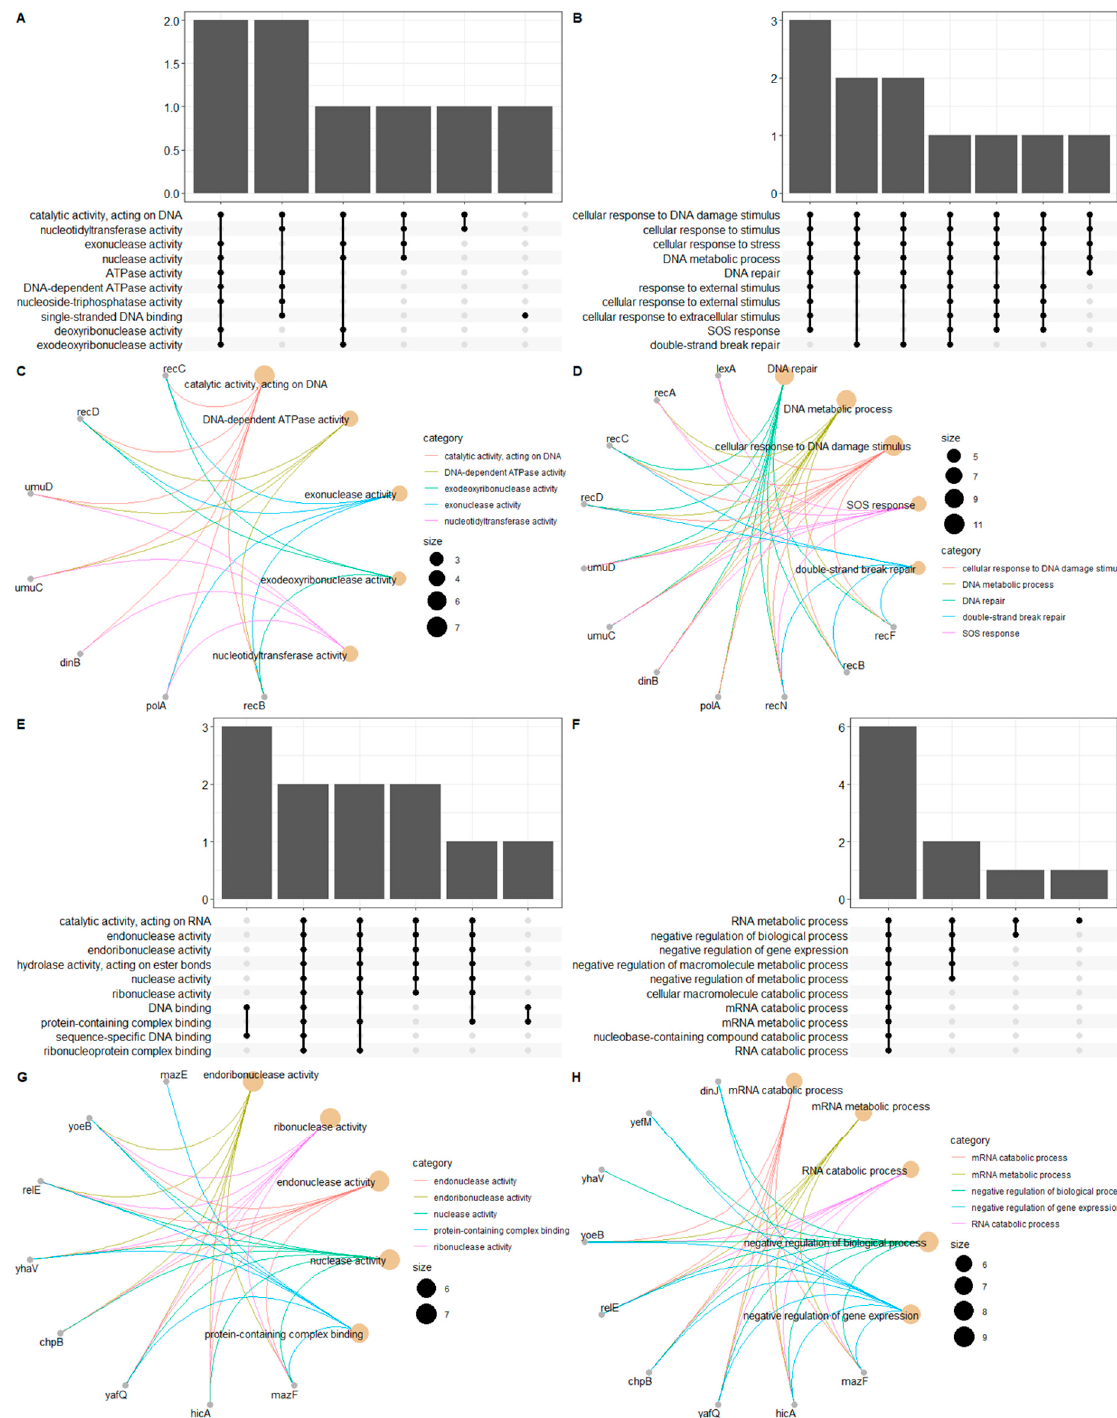
Figure 7. Functional enrichment analysis. ( A )–( D ) Show the enrichment analysis of the cluster involving lexA as the seed node, and ( E )–( H ) show the enrichment results of the cluster involving yafQ-hicA-hicB as seed nodes (Figure 5). In panels ( A , B , E , F ), upset plots are drawn to visualize the intersection between the gene ontology (GO) terms in a given ontology (horizontal labels). Every possible intersection is represented by the bottom plot, and the frequency (i.e., number of genes) is shown on the top vertical bar plot. In panels ( C , D , G , H ), circular gene-concept networks are drawn to visualize the interaction between each gene and its associated GO term. The edges are colored according to the GO term, and the node size reflects the number of genes associated with each category. Panels ( A , C , E , G ) correspond to enrichment results for GO “molecular function” ontology, while panels ( B , D , F , H ) correspond to enrichment results for GO “biological process” ontology.